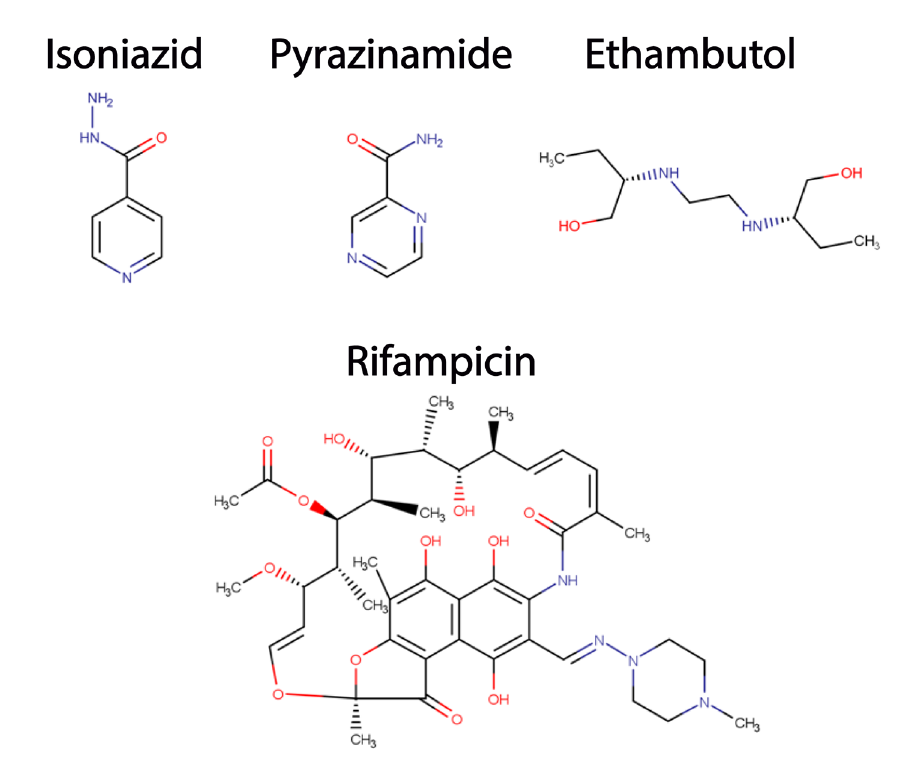
Figure 1 - First-line drugs used in tuberculosis treatment. Structures for first-line drugs used in tuberculosis treatment, Isoniazid, Pyrazinamide, Rifampicin and Ethambutol. Structures were drawn using Marvin software (Cherinka et al ., 2019).